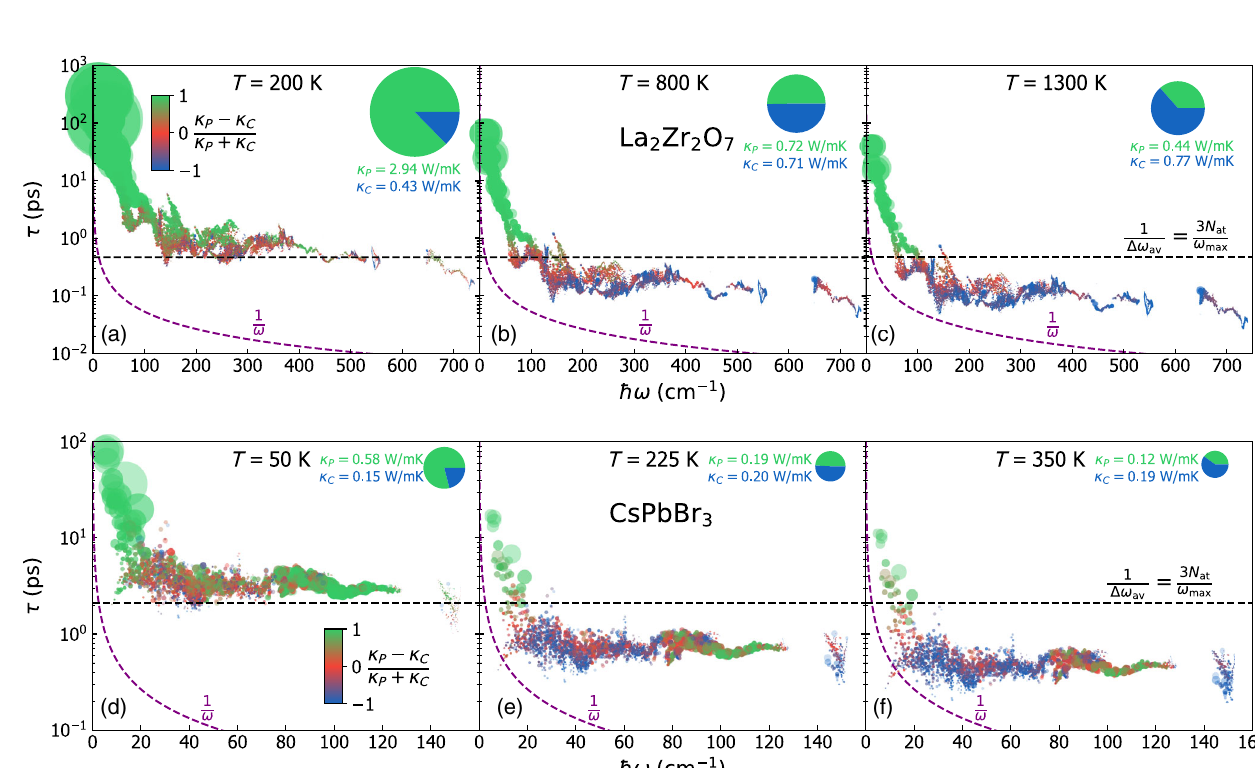
FIG. 8. Phonon lifetimes in La 2 Zr 2 O 7 and CsPbBr 3 . We show the phonon lifetimes τ ð q Þ ¼ ½ Γ ð q Þ s (cid:2) − 1 as a function of the energy ℏ ω ð q Þ s for La 2 Zr 2 O 7 [at a temperature of 200 K (a), 800 K (b), and 1300 K (c)], and for CsPbBr 3 [at a temperature of 50 K (d), 225 K (e), and 350 K (f)]. The area of each circle is proportional to the contribution to the total conductivity and colored according to the origin of the contribution: green for particlelike propagation of populations; blue for wavelike tunneling of coherences; intermediate colors represents phonons contributing to both mechanisms, with red corresponding to 50% of each [see Eq. (54)]. The dashed black line is the Wigner limit in time, corresponding to a phonon lifetime equal to the inverse of the average interband spacing [ τ ¼ ½ Δ ω Eq. (52)]. We highlight how the nonsharp crossover from dominant particlelike conduction to dominant wavelike conduction occurs around this value, in agreement with the theoretical predictions from the Wigner framework [Eq. (53)]. The dashed purple hyperbola is the Ioffe-Regel limit in time, τ ¼ 1 = ω ; the Wigner formulation is applicable when phonons have lifetime longer than this value, a condition which is always verified here. The pie charts have an area proportional to the total conductivity, and the slices resolve the populations conductivity (particlelike, green) and the coherences conductivity (wavelike,